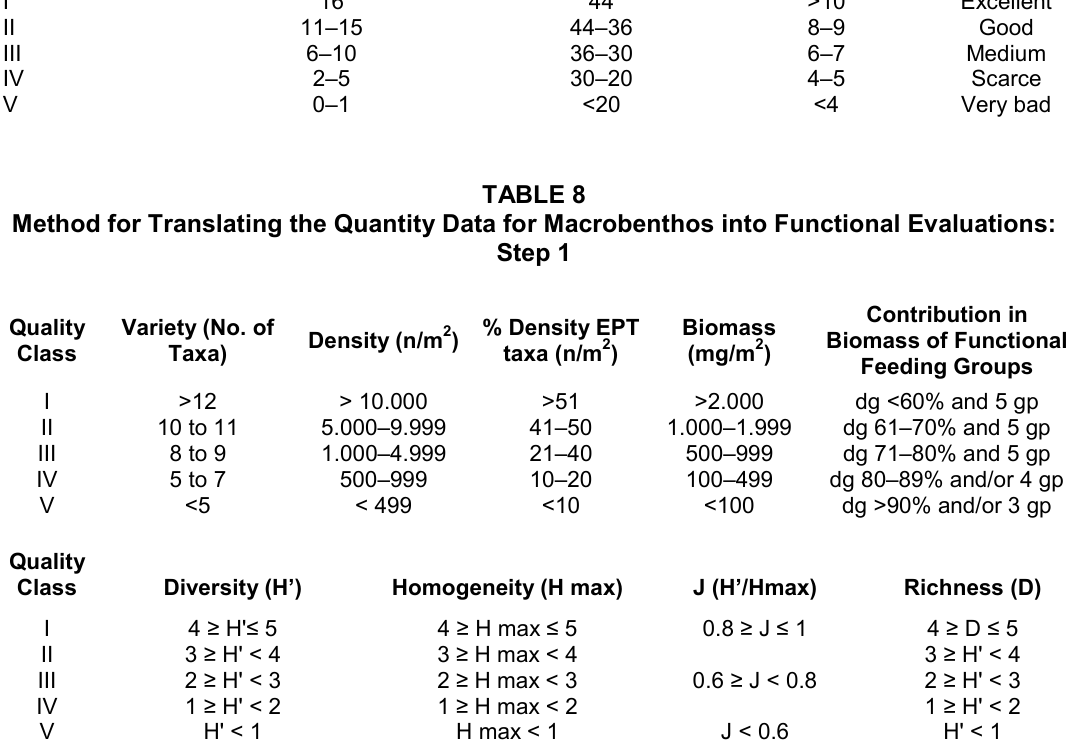
Translation of the Qualitative Results on the Macrobenthic Fauna into Quality Classes Quality Class